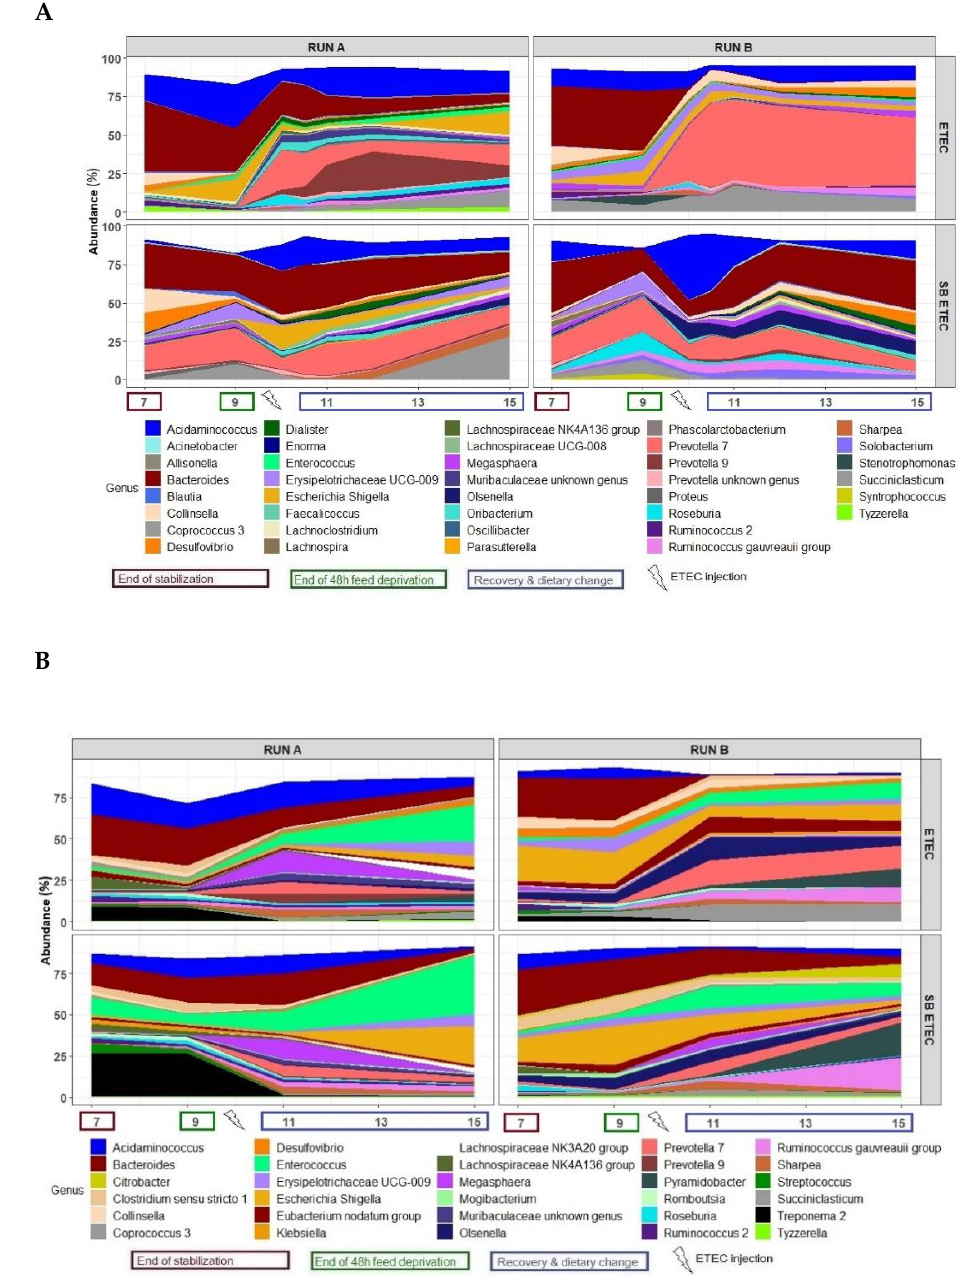
Figure 5. Mean relative abundances of the 30 main bacterial genera in the bioreactor medium ( A ) on the mucin beads ( B ) of the MPigut-IVM during the ETEC and SBETEC conditions.